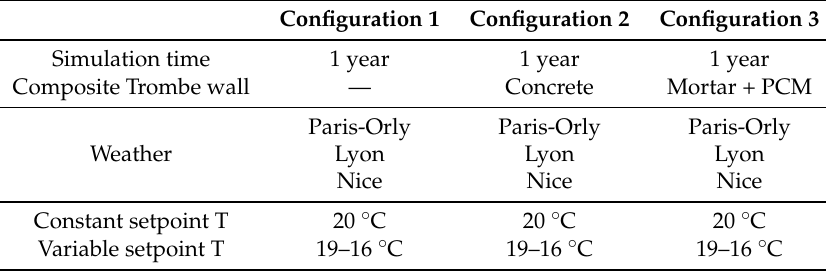
Table 5. Summary table for the three